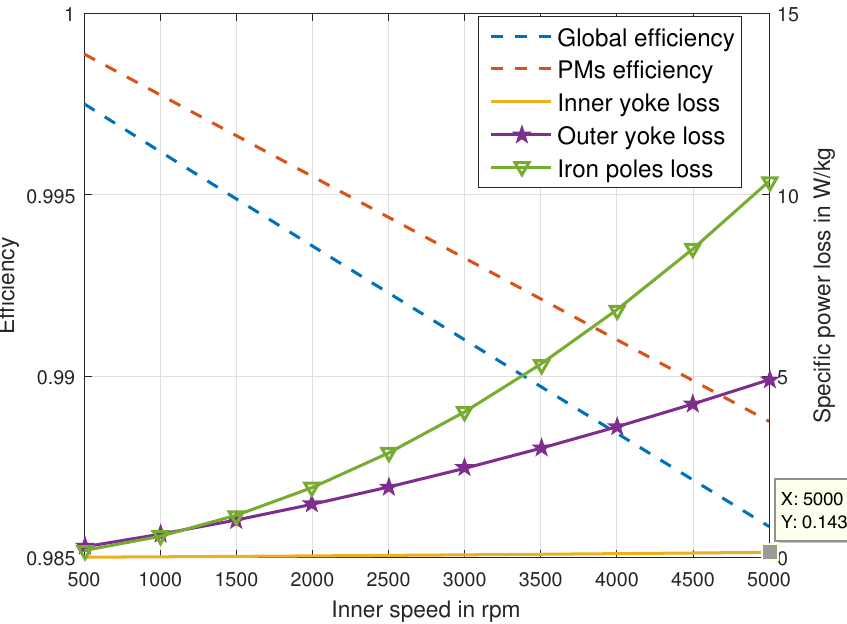
Figure 16. Global efficiency, permanent magnets efficiency and specific iron loss plots varying the rotational speed. The efficiency decay is practically linear in this speed range and above ω in = 1000 rpm the highest specific losses are in the iron